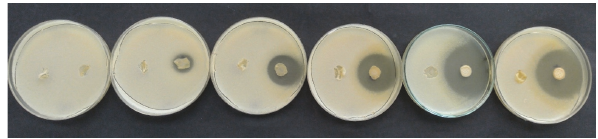
Figure 7: Inhibition zones of chitosan films with 0.5, 1, 2, 3, 4, and 5% wt. of the marjoram (left) and oregano (right) oils on Aspergillus niger